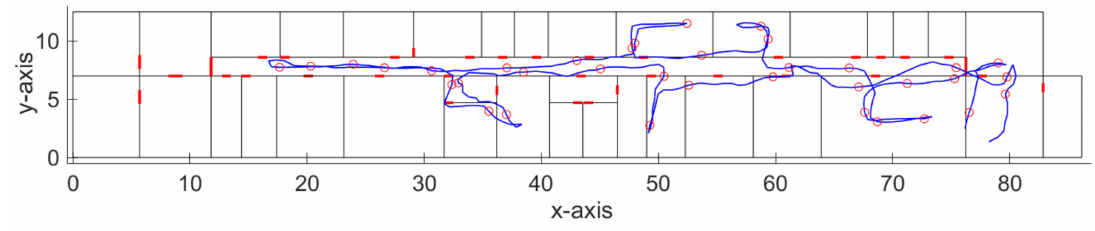
Figure 4. Track recovered by the dead reckoning algorithm with detected reference